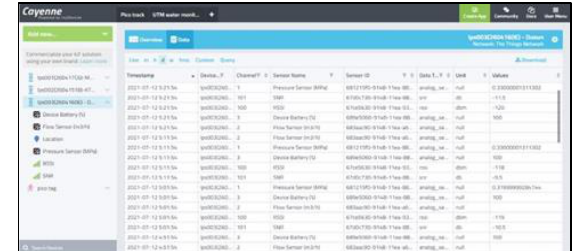
Figure 11. Real-Time Data